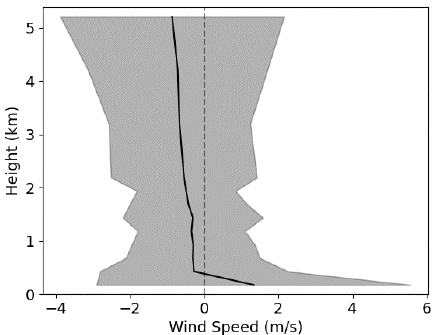
Figure 3. Iqaluit Ka-band radar bias (black line) and standard deviation of the differences (STDE, shaded region) compared to radiosonde measurements for coincident observations from 15 September to 16 October 2018. Only radar observations within 30min of radiosonde launch were